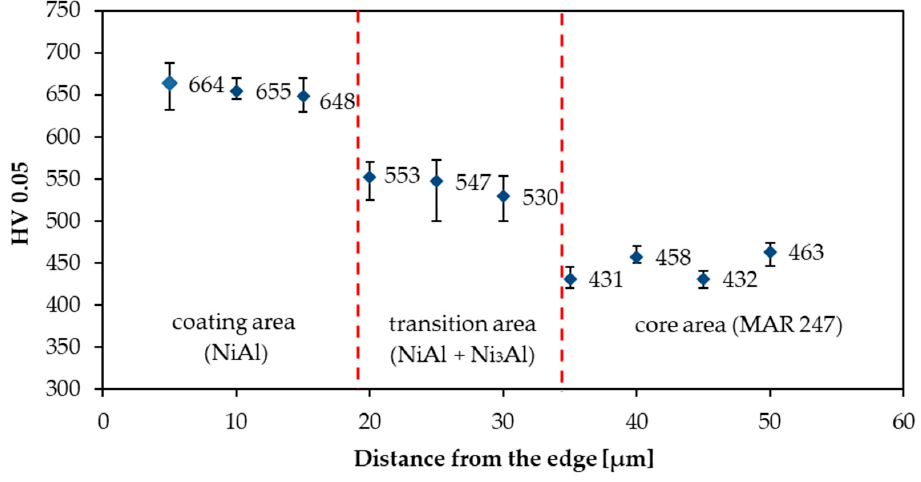
Figure 3. Hardness distribution in the cross-section of coating obtained.